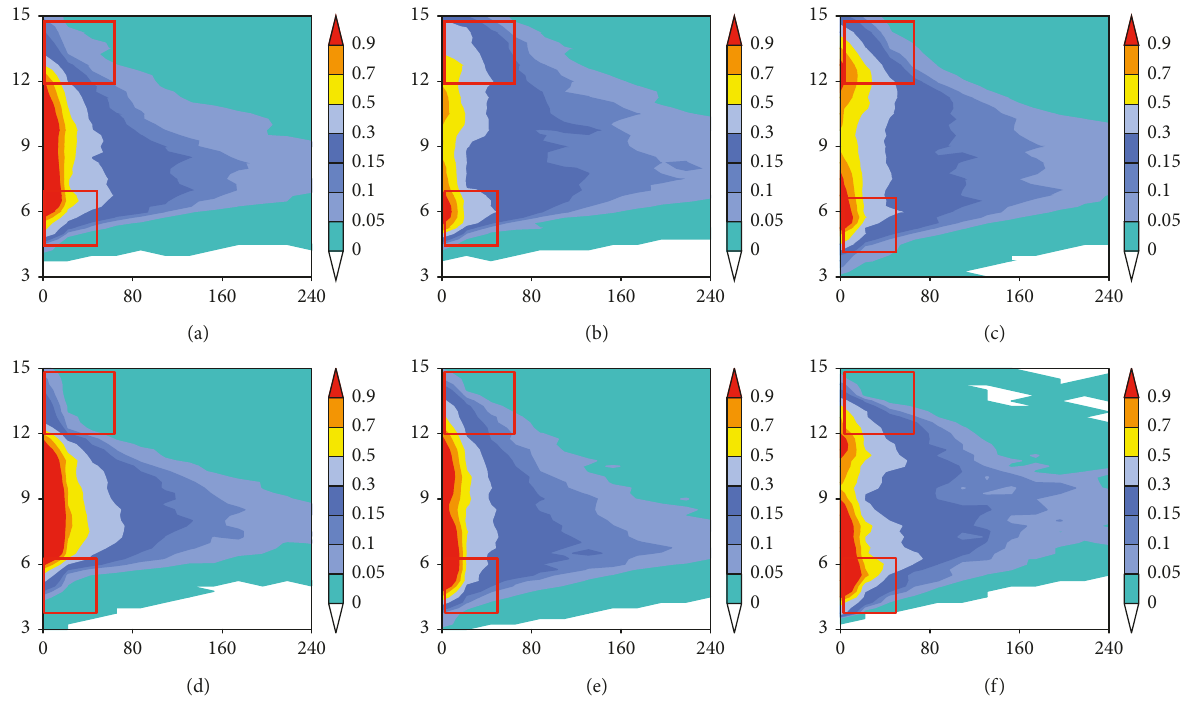
Figure 11: The vertical distribution of the number concentration of ice crystals corresponding to different types of TPV category cloud clusters over each key region: (a) iwc_TP (IC); (b) iwc_ESTP (IC); (c) iwc_MYR (IC); (d) iwc_TP (ILC); (e) iwc_ESTP (ILC); (f) iwc_MYR (ILC). ((a) TP, (b) ESTP, and (c) MYR represent the pure ice phase of the TPV category cloud clusters, and panels (d) TP, (e) ESTP. and (f) MYR represent the ice-water mixed-phase of TPV category; X -axis represents particles number concentration (unit: mg/m 3 ); Y -axis represents altitude (unit: km); shaded color represents the percentage of frequency (unit: %); and red and yellow box represents the significant discrepancy area)).